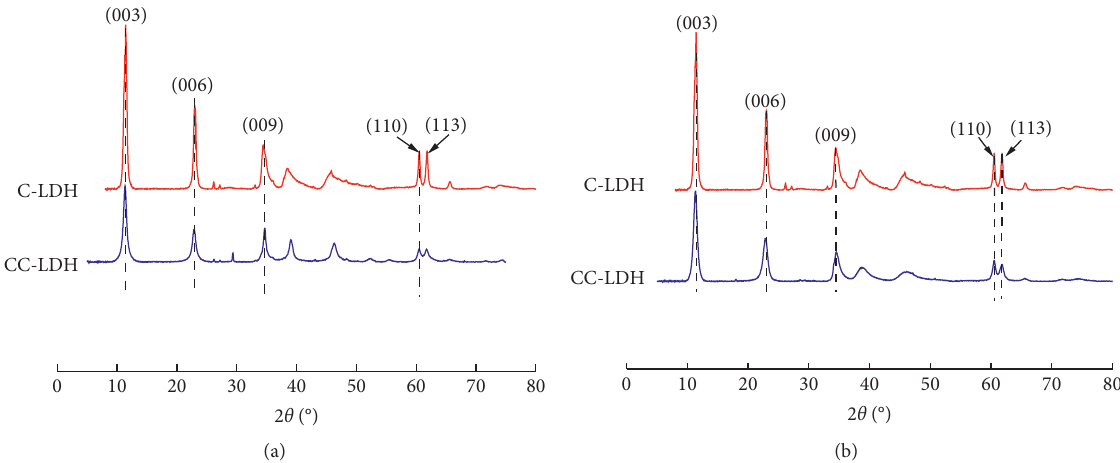
Figure 6: XRD images of (a) C-LDH and (b) N-LDH before and after adsorption of chloride ions.